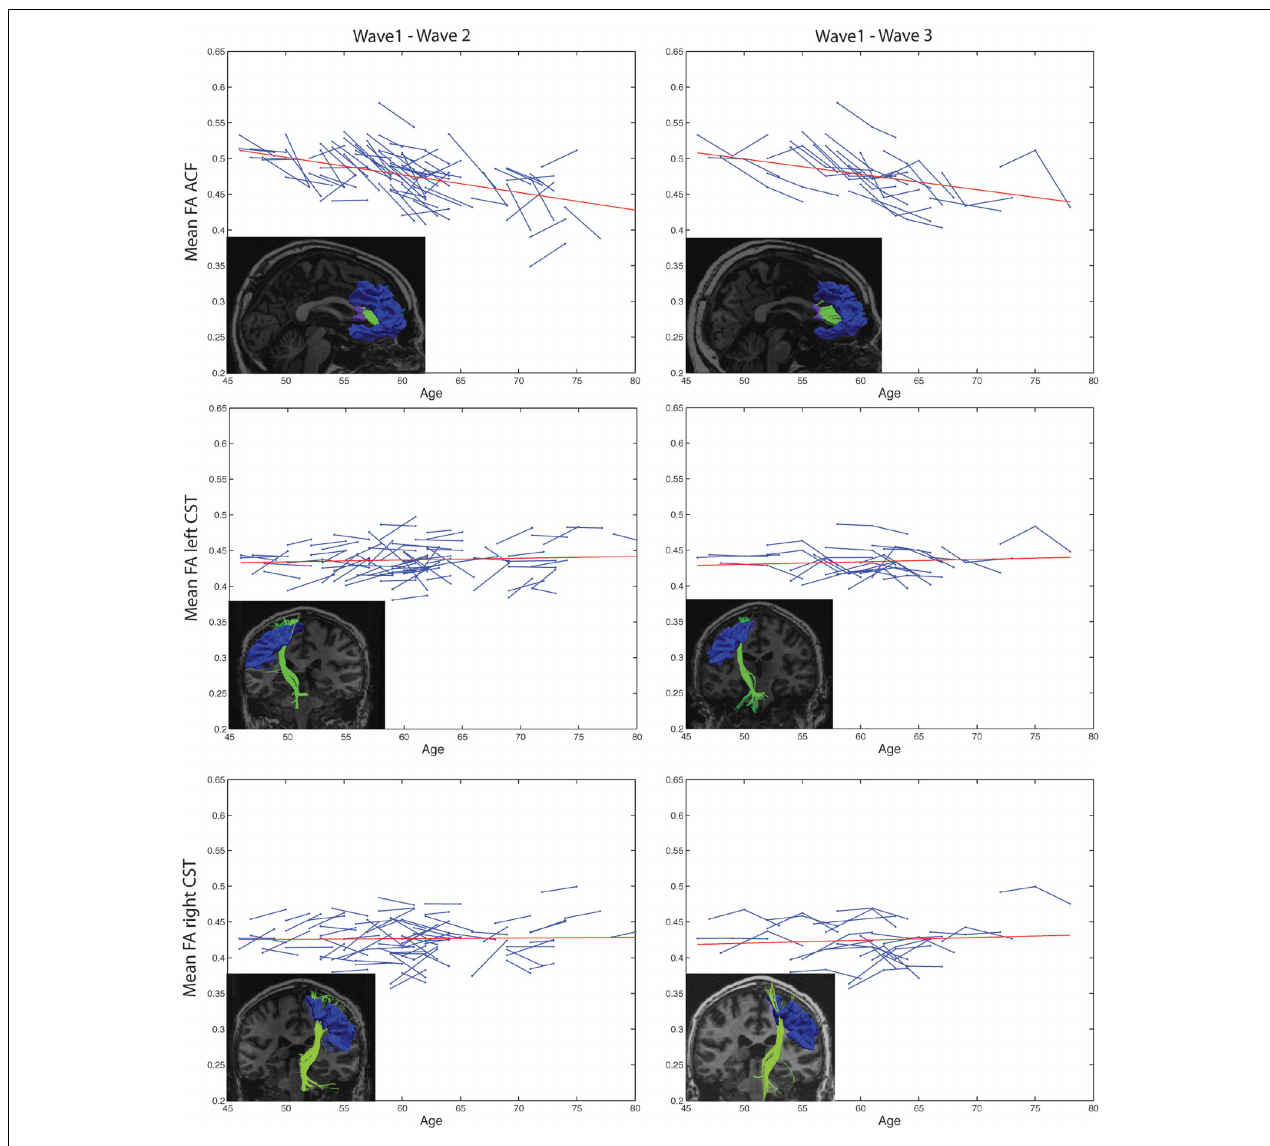
FIGURE 3 | Subject-specific longitudinal tract mean FA in anterior callosal fiber (ACF) bundle, and left and right corticospinal tract (CST) during aging. Left column: Tract mean FA for each participant at Wave-1 and Wave-2. Right column: Tract mean FA for the subset of participants having three MRI examinations, i.e., at Wave-1, Wave-2, and Wave-3. For